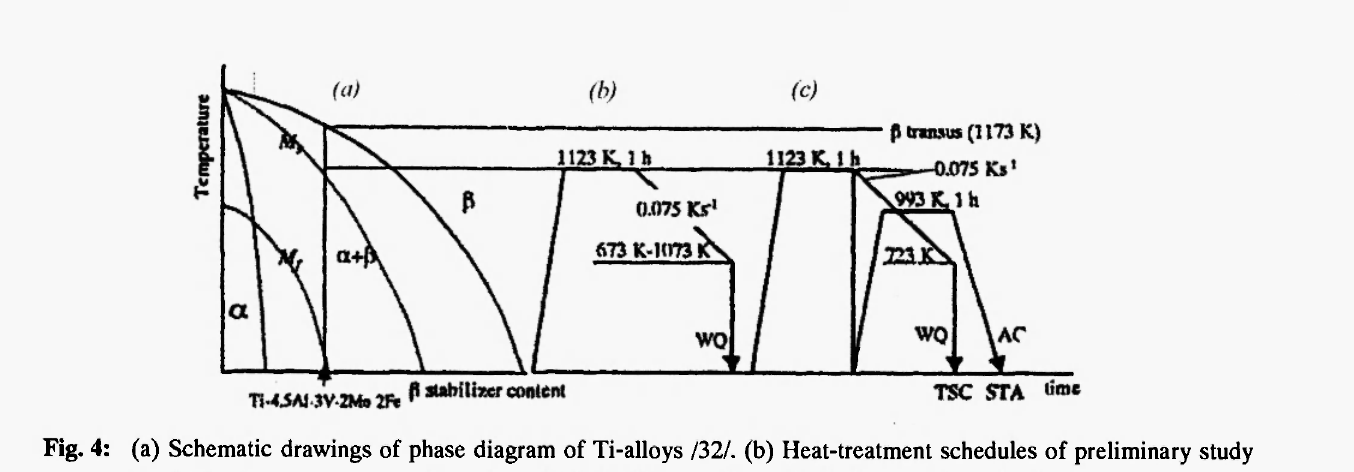
Fig. 4: (a) Schematic drawings of phase diagram of Ti-alloys /32/. (b) Heat-treatment schedules of preliminary study to obtain the coarsest secondary phase /32/. (c) Core study to obtain improved mechanical properties of the alloy I3>2I.